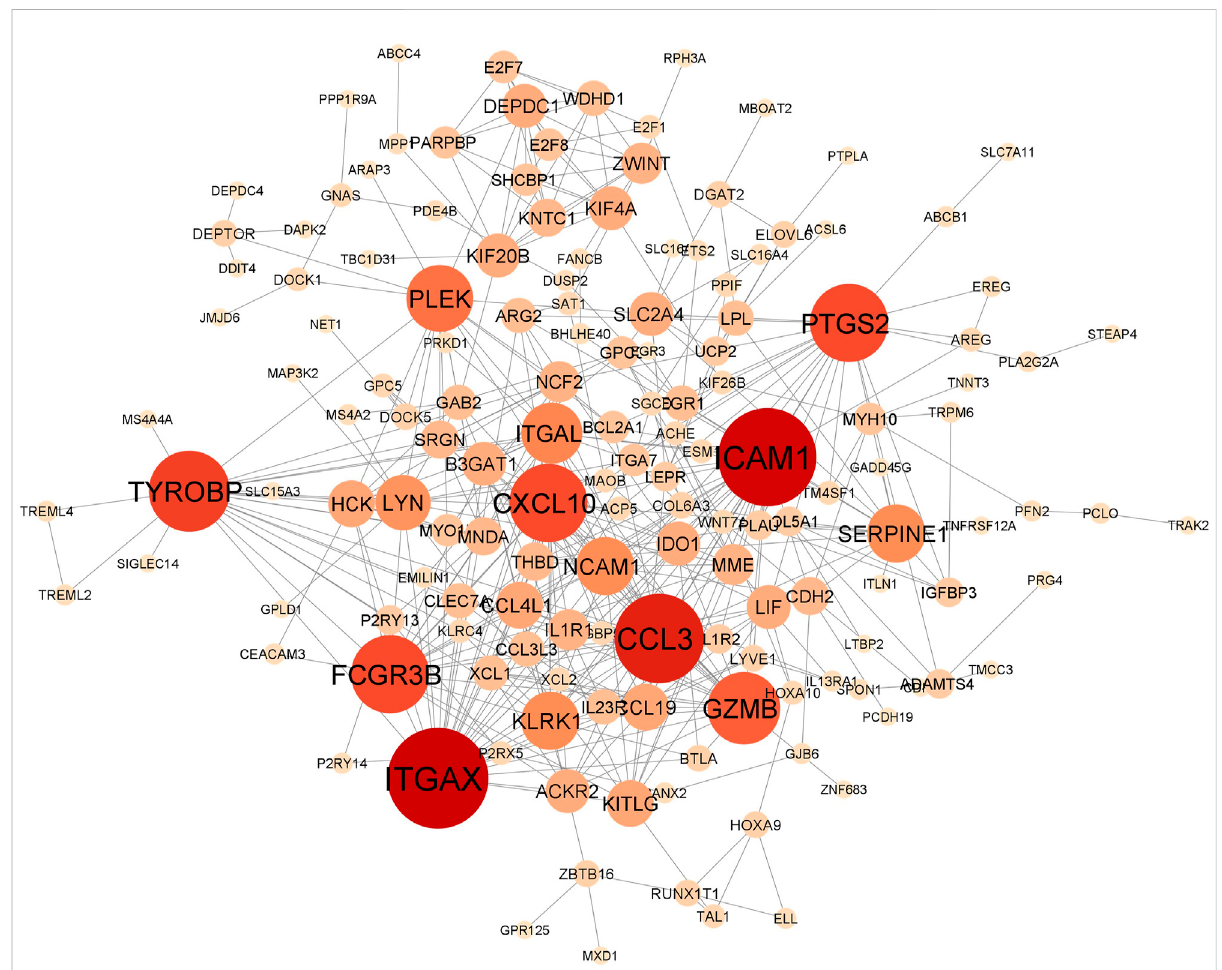
FIGURE 4 Protein-protein interaction network of 274 genes shared by the comorbidities and COVID-19 infections and classi fi ed by their degree of centrality. Node size is proportional to the degree of connection. Top gene, with at least 15 connections, includes ITGAX, ICAM1, CCL3, TYROB, PFCGR3B, PTGS2, CXCL10, GZMB, PLEK, ITGAL, NCAM1, KLRK1 and SERPINE1